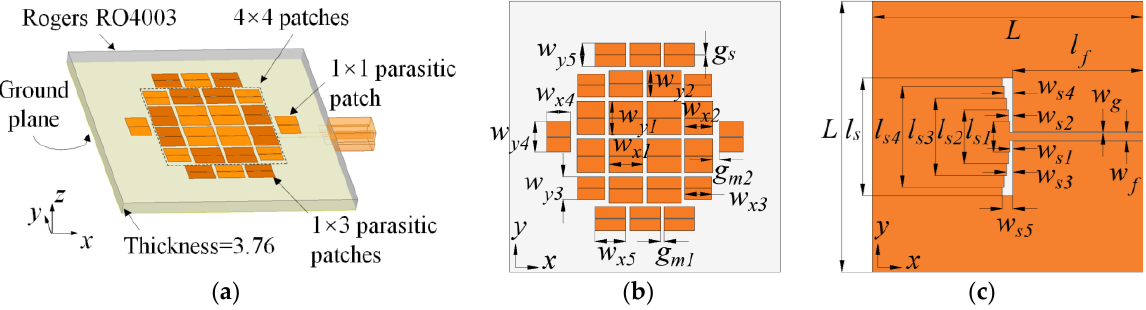
Figure 1. Configuration of the proposed antenna. ( a ) The 3D model. ( b ) Top view with the metasur- face (MTS3). ( c ) Bottom view with the CPW-fed slot. w x 1 = 8.80, w y 1 = 8.80, w x 2 = 7.20, w y 2 = 6.80, w x 3 = 7.00, w y 3 = 6.00, w x 4 = 6.20, w y 4 = 8.00, w x 5 = 7.90, w y 5 = 6.20, g m 1 = 1.00, g m 2 = 1.70, g s = 0.20, L = 70.00, l s 1 = 8.01, l s 2 = 14.01, l s 3 = 20.01, l s 4 = 26.01, l s = 30.40, w s 1 = 0.80, w s 2 = 1.30, w s 3 = 1.80, w s 4 = 2.30, w s 5 = 2.80, w g = 0.20, w f = 2.01, and l f = 33.6, (unit: mm).